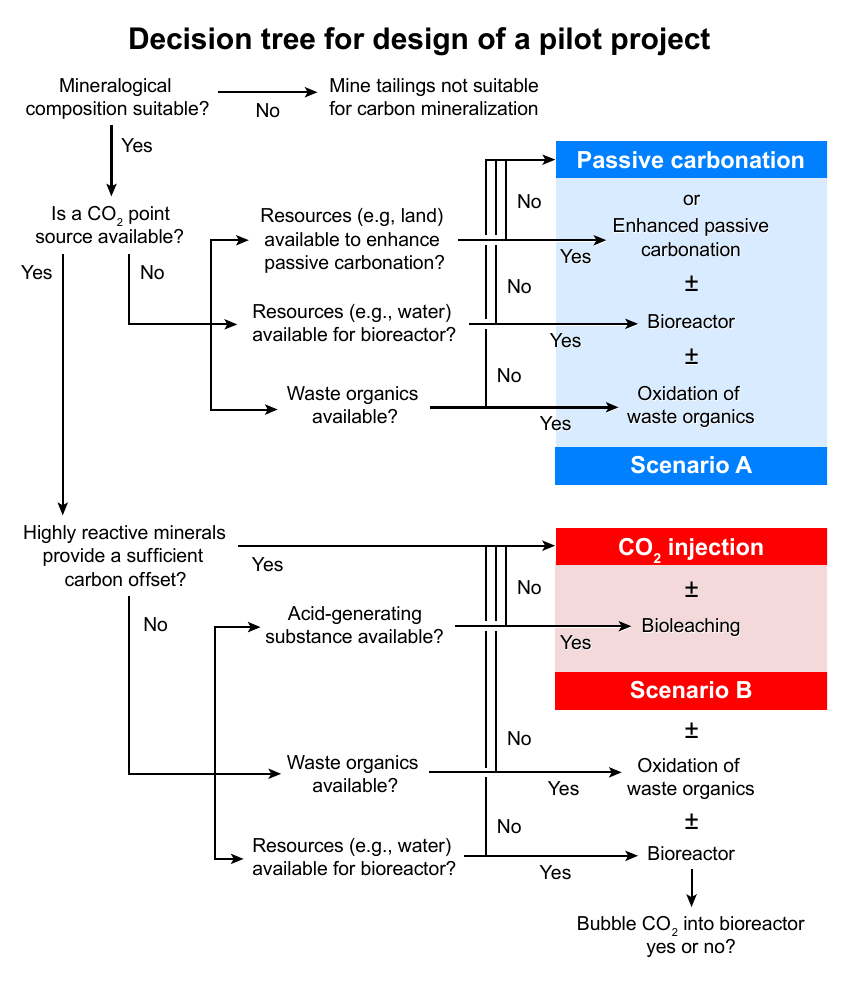
Figure 6. Decision tree for developing a pilot project for accelerating carbon mineralization in mine